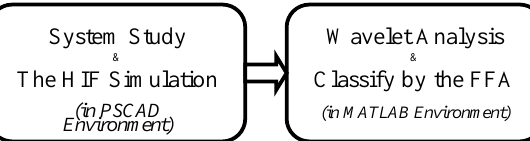
Figure 5.The schematic diagram of the execution of the proposed algorithm. The number of systems running in PSCAD is